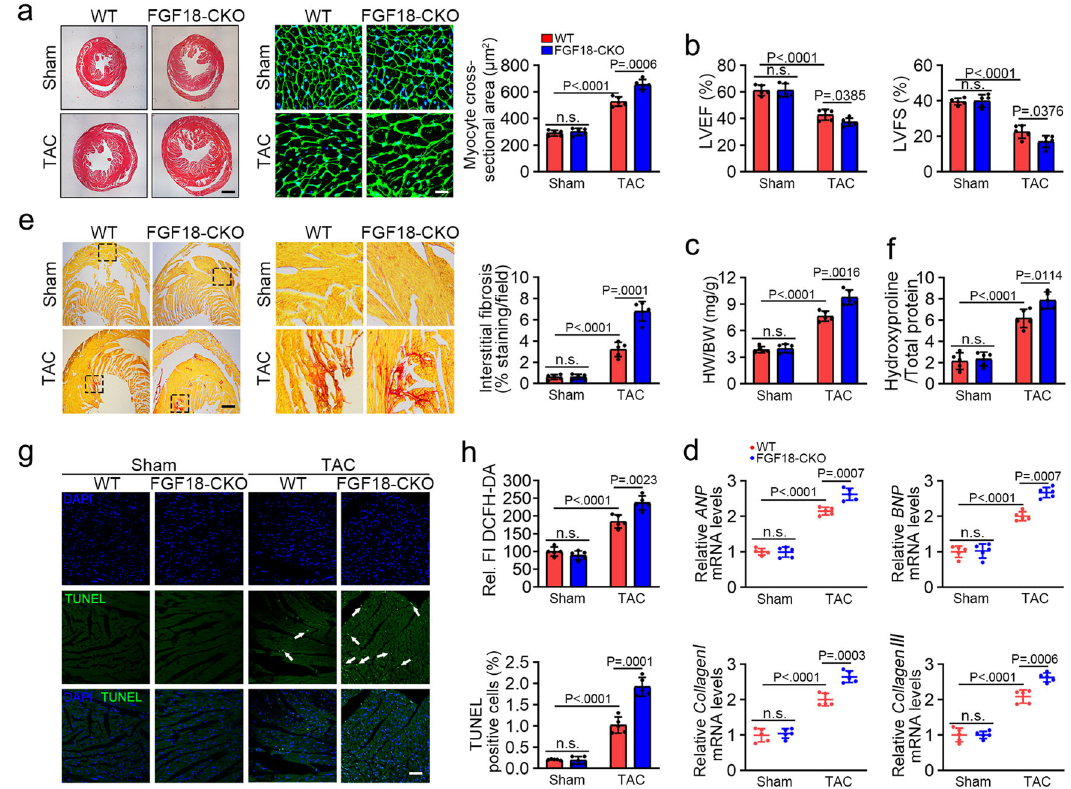
Fig. 4 | Cardiomyocyte-speci fi c FGF18 deletion exacerbates pathological car- diachypertrophyinvivo. Fgf18 f/f and Fgf18 - CKO mice( α MHC-MerCreMer; Fgf18 f/f ) were intraperitoneally injected with tamoxifen at 6 weeks old male mice, and 2weeks after theinjection,thesemiceweresubjected toShamorTACsurgeryand harvest after 6 weeks. a Histological analyses of the HE staining and WGA staining ( n =5. Scale bar=0.6mm for left HE staining; scale bar=20 μ m for right WGA staining). Statistical results for the sectional cell area (right panel). n =5. b Representative echocardiographic images and echocardiographic data for LVEF and LVFS are shown. n =5. c Statistical results for the ratios of heart weight/body weight(HW/BW)intheindicatedgroups. n =5. d Real-timequantitativePCRassays.